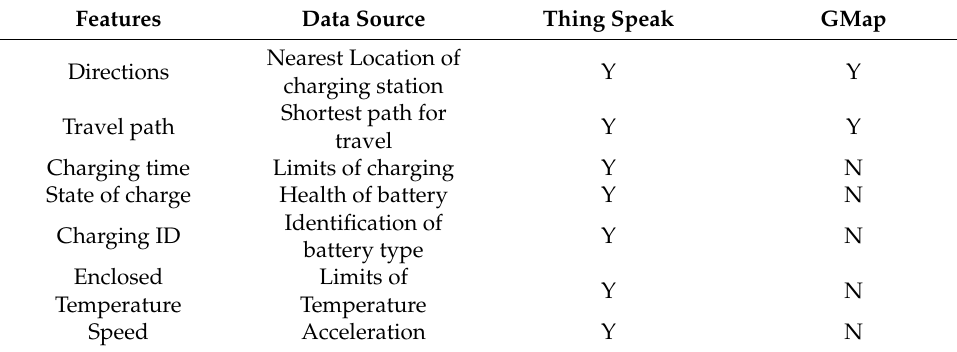
Figure 3. Estimation of capacity for different time periods.